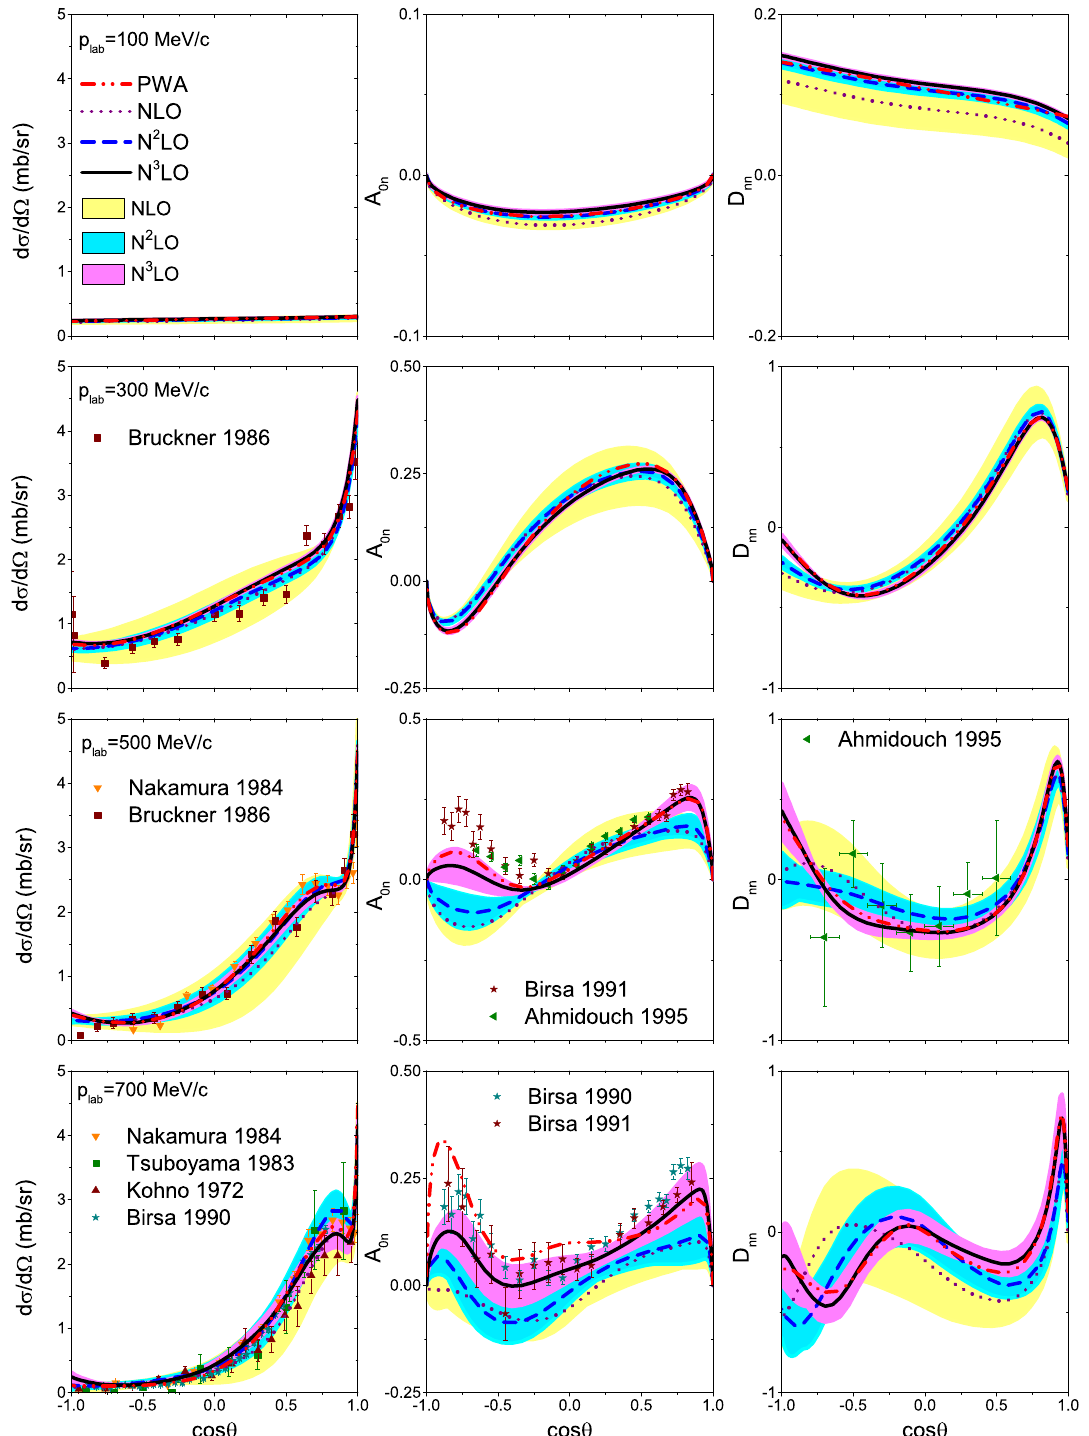
Figure 12 . Di(cid:11)erential cross sections, analyzing powers and spin correlation parameters D nn for charge-exchange scattering. Notations are described in the text. Data are taken from refs. [78, 87, 91{93] (di(cid:11)erential cross sections), [93{95]. (analyzing powers), and [95] ( D nn ). Note that the data for A on are for 546 and 656 MeV/c, respectively.